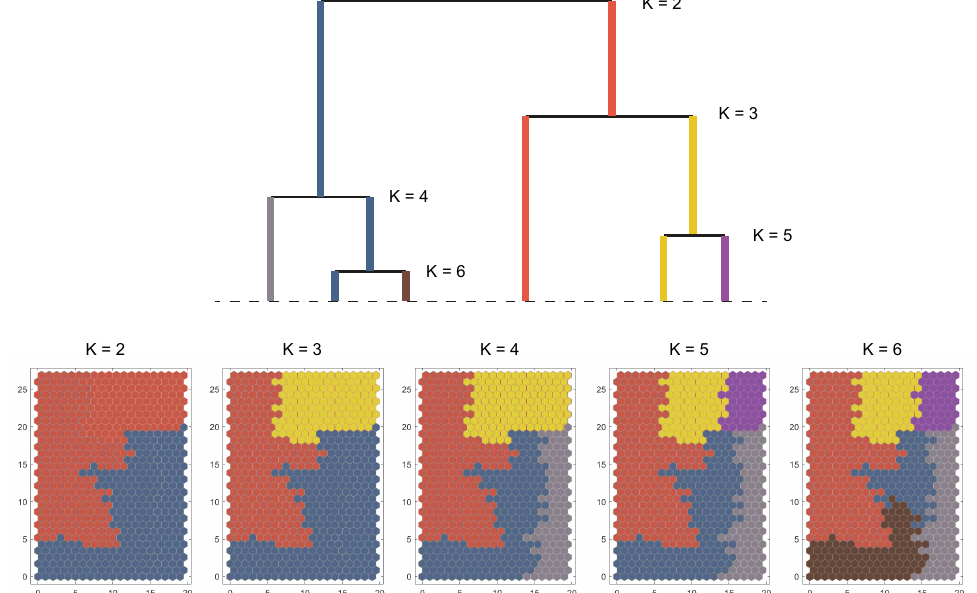
Figure 5. Clustering definition by applying the Ward technique. In the case of K = 4, Cluster 1 is represented by the color gray; Cluster 2 in blue; Cluster 3 in red; and Cluster 4 in